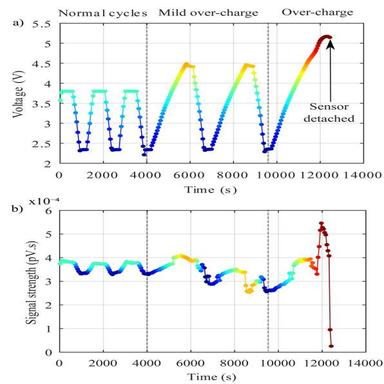
Acoustic signal in OC a) Voltage vs time plot; b) Signal strength vs time plot. Fig. 4. Mapping for OC of prismatic cell. a) Normal cycling; b) All the cycles.